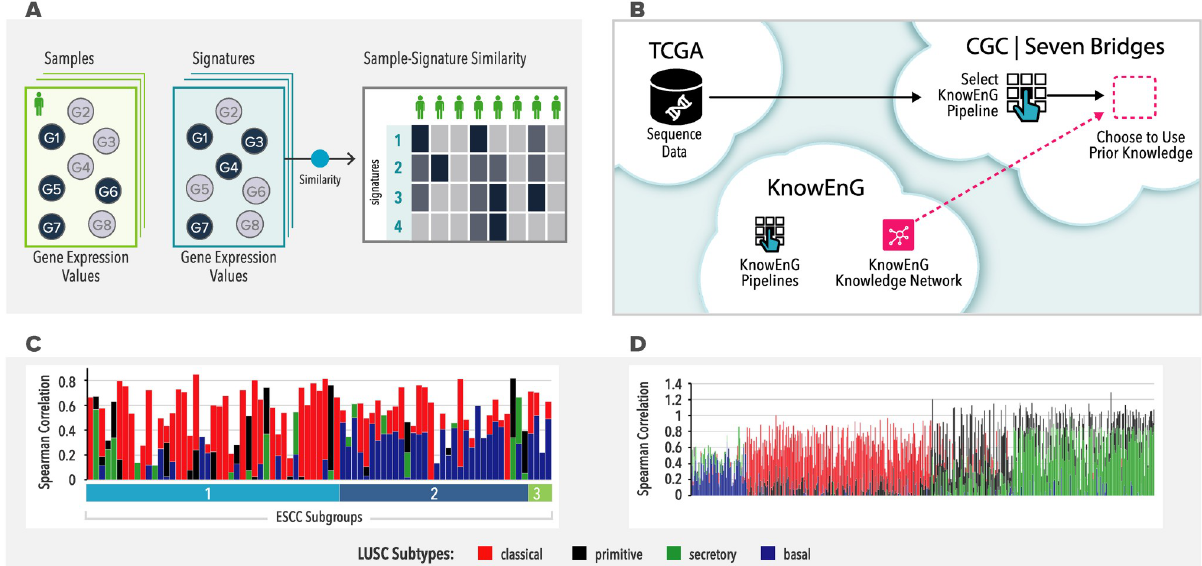
Fig 5. Signature analysis pipeline. (A) Each user-uploaded expression profile (sample) is matched against expression profiles in a predetermined collection (signatures) and match scores for all sample-signature pairs are reported by the pipeline. (B) Signature Analysis and other KnowEnG pipelines can be executed seamlessly on the third-party platform of SB-CGC that hosts a large repository of cancer data and associated tools. The pipelines are published on SB-CGC as a native workflow and the Knowledge Network is transferred “under the hood” from the KnowEnG Cloud when needed by a pipeline. (C) Signature Analysis of 79 ESCC samples, distributed into 3 subgroups, matched against 4 LUSC signatures (subtypes) using Spearman’s Correlation Coefficient. (D) Signature analysis of 551 LUSC samples available on the SB-CGC, matched against 4 LUSC signatures. ESCC, esophageal squamous cell carcinoma; KnowEnG, Knowledge Engine for Genomics; LUSC, lung squamous cell carcinoma; SB-CGC, Seven Bridges Cancer Genomics Cloud.